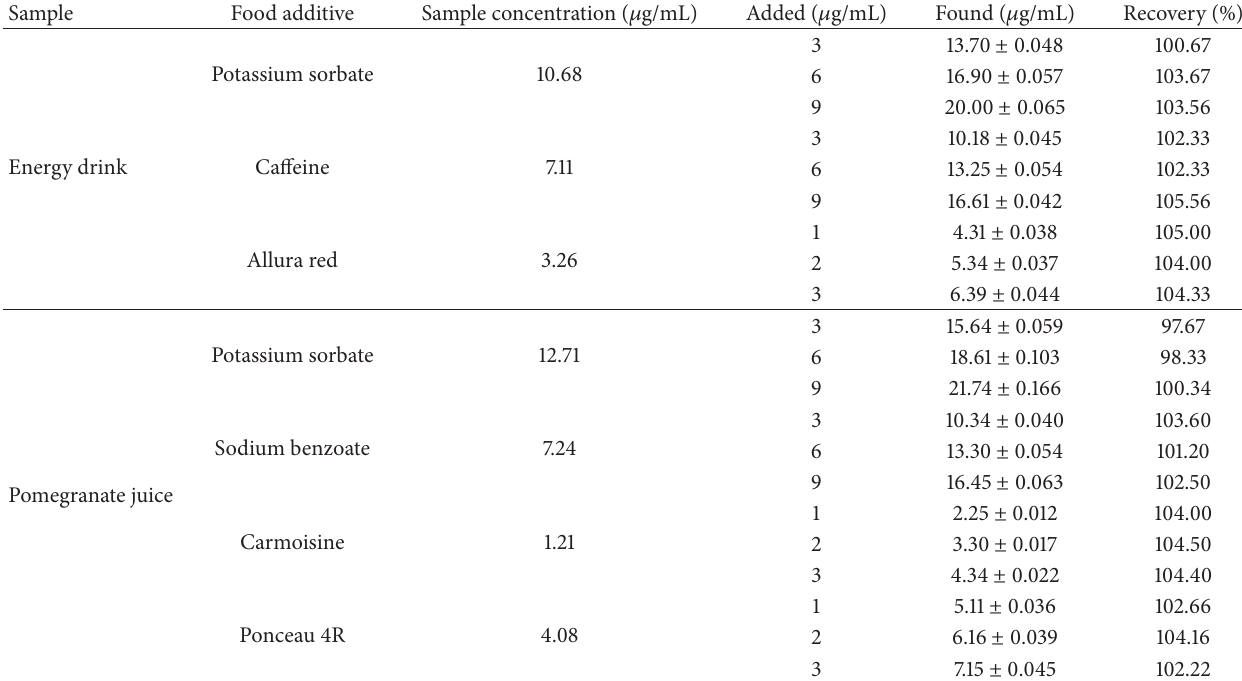
Table 6: Results of accuracy studies (mean value ± standard deviation, 𝑛 = 5 ).